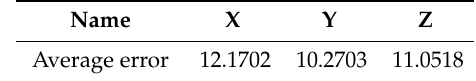
Table 4. Average error of the system (The average error in three dimensions).